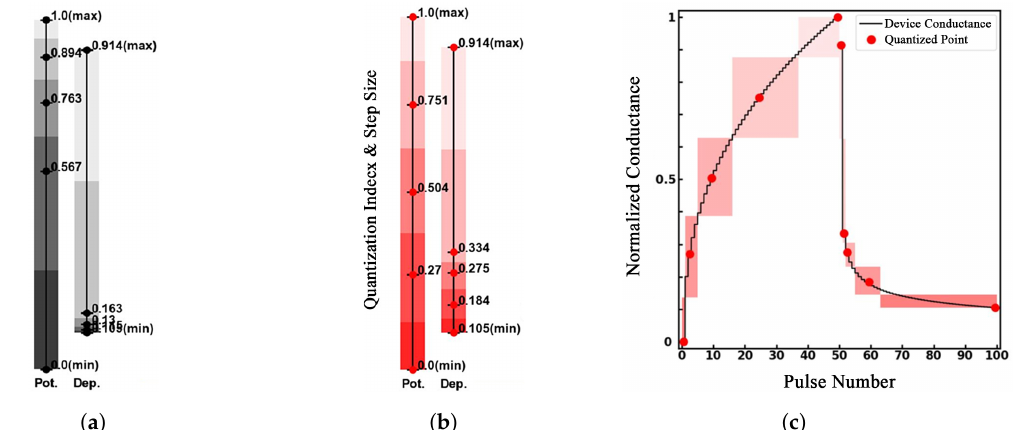
Figure 8. Quantization index (Quantized Point) and step size of ( a ) typical and ( b ) proposed method, and ( c ) quantized potentiation and depression over the pulse